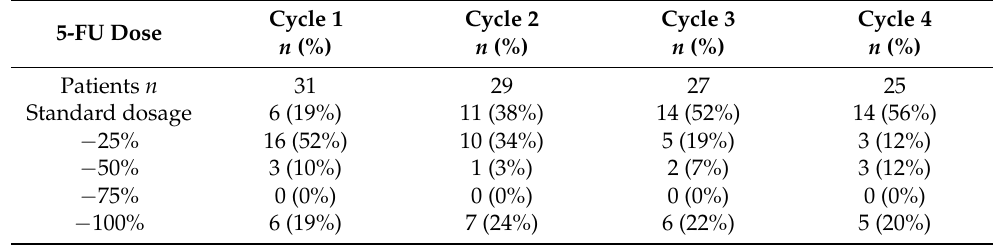
Table 4. Dosage adjustment of 5-FU bolus during the first four chemotherapy treatment cycles in deficient patients ( n =